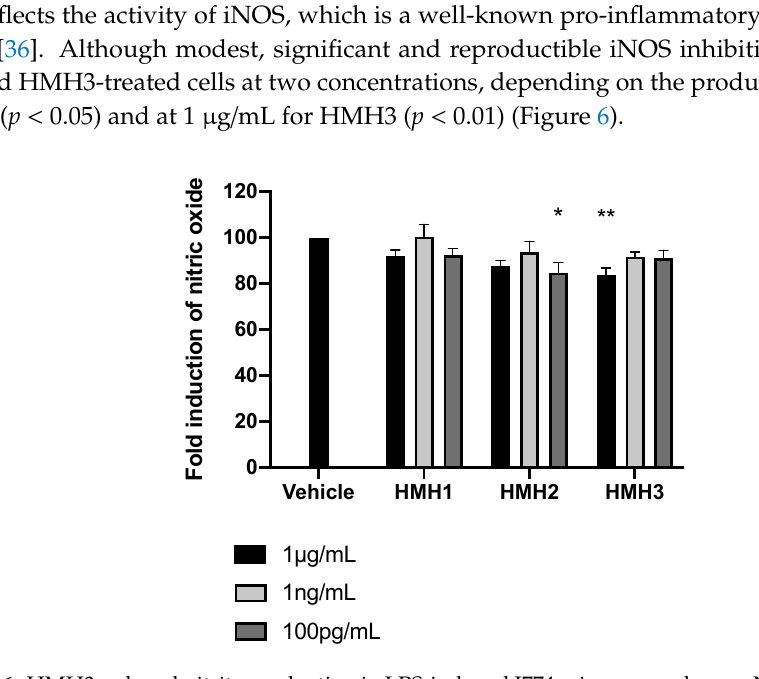
Figure 6. HMH3 reduced nitrite production in LPS-induced J774 mice macrophages. Nitrite production in culture media after inflammation induction by LPS in mice treated with HMHs at three concentrations (1 µg/mL, 1 ng/mL, and 100 pg/mL), n = 6, means ± SEM, one-way ANOVA post hoc Dunnett test, * p < 0.05, and ** p < 0.01.